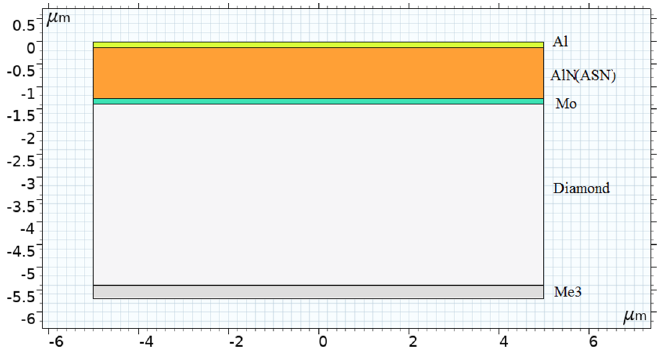
Figure 2. Model of diamond-based MPS. The layer thicknesses are shown on an arbitrary scale.